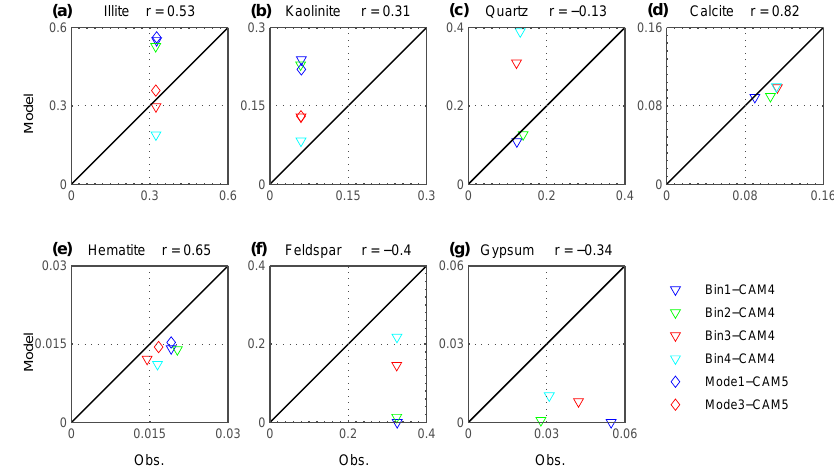
Figure 4. Relative mass abundance of minerals near the surface as modeled compared to observations from Kandler et al. (2009) for CAM4, bins 1–4, and CAM5, mode 1 and mode 3. The month of May was averaged from 2006 to 2011 for the models. The CAM4 comparison is for quartz (c) , calcite (d) , feldspar (f) and gypsum (g) . Comparisons for CAM4 and CAM5 include illite (a) , kaolinite (b) and hematite (e) .